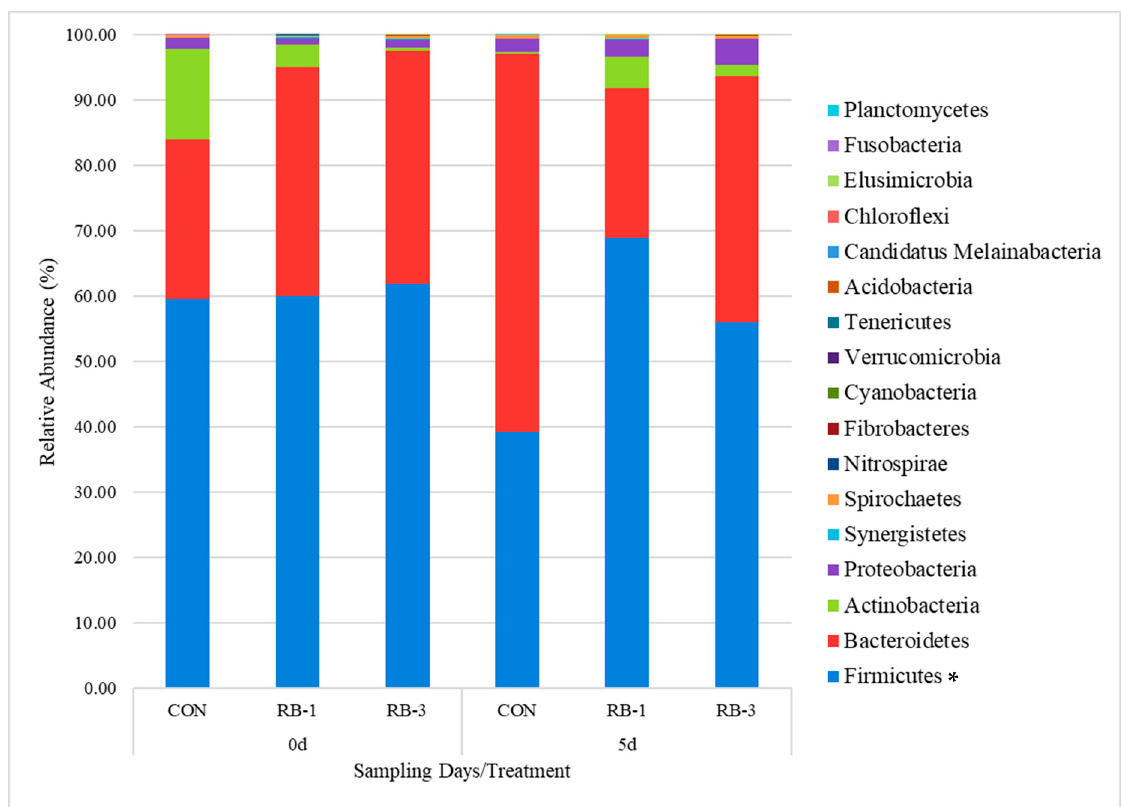
Figure 3. Phylum-level bacterial taxonomic compositions of Holstein Friesian cow rumens at 0 and 5 d of treatment supplementation. CON (no buffer added), negative control; RB-1 (30% calcium oxide, 10% processed coral, 30% magnesium oxide, 30% sodium bicarbonate); RB-3 (20% calcium oxide, 10% processed coral, 40% magnesium oxide, 30% sodium bicarbonate). Asterisks (*) denote significant differences ( p < 0.05).